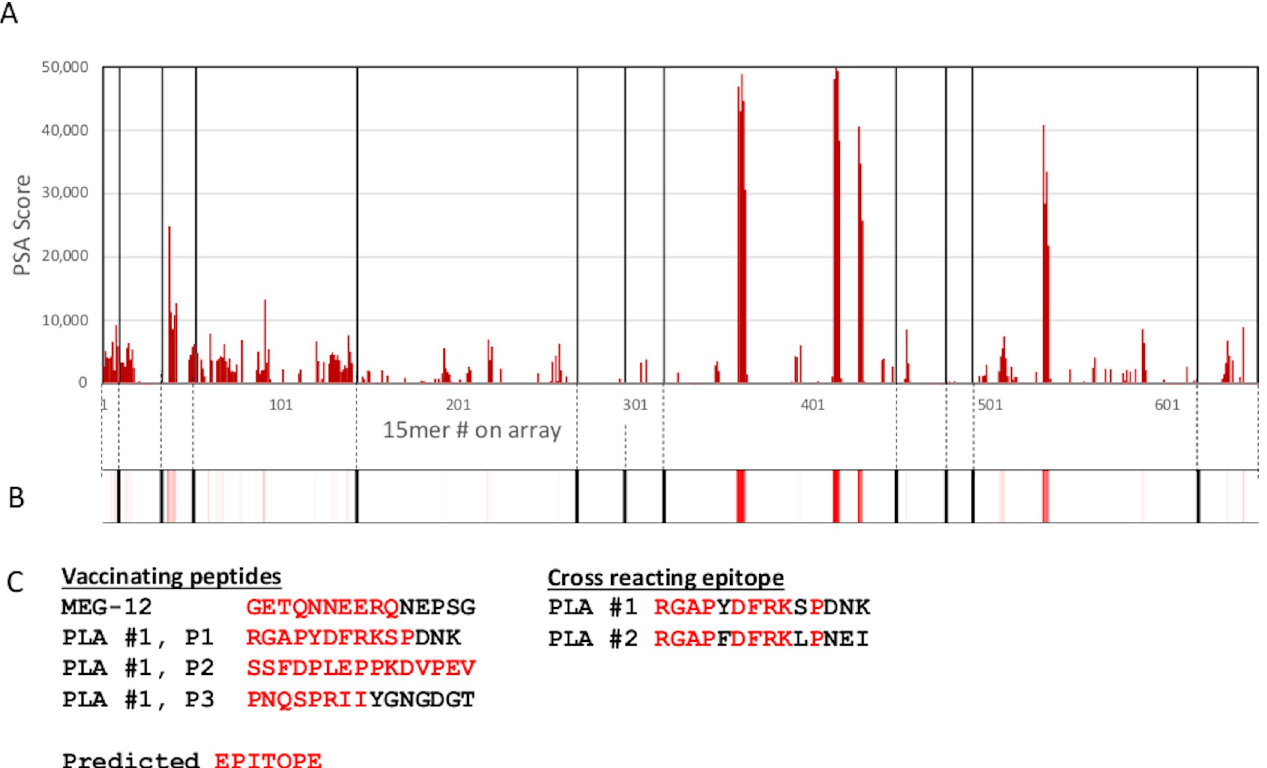
Fig 3. Positive control sera reacted with Array 2. A. Linear graphical plot showing reactivity of mouse antibodies at 1:2000 dilution against synthetic peptides from MEG-12 and Phospholipase A #1 (PLA #1). The x axis represents cell position on the array and the y axis the PSA score for each cell. B, corresponding heatmap on a scale 5000 to 50000. C. Peptide sequences used for vaccination of mice and a comparison of the cross-reacting epitope on PLA #1 and PLA #2. Note that a tyrosine and a serine in PLA #1 have been substituted by a phenylalanine and a leucine in PLA #2 with minimal effect on peptide reactivity.